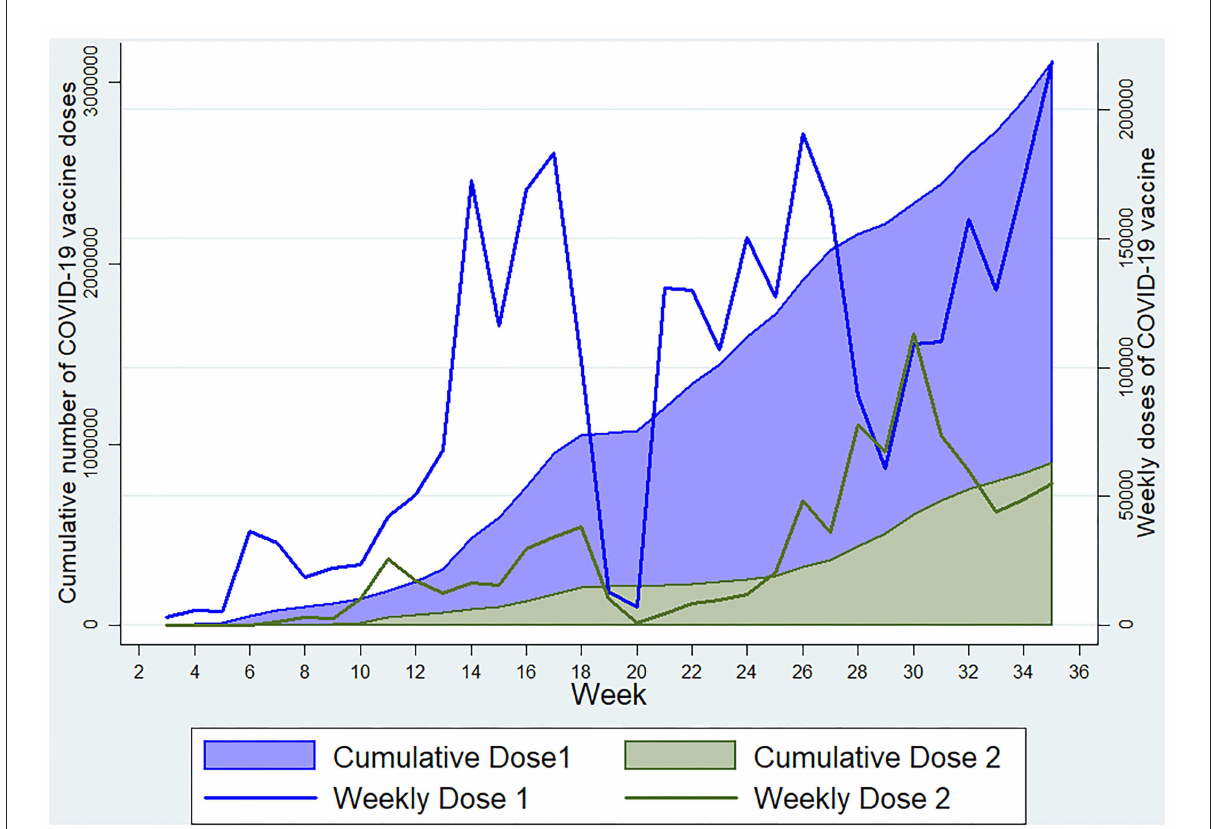
FIGURE5 Weekly and cumulative doses of COVID-19 vaccine in Kashmir Division till 3 September 2021 (Data source: